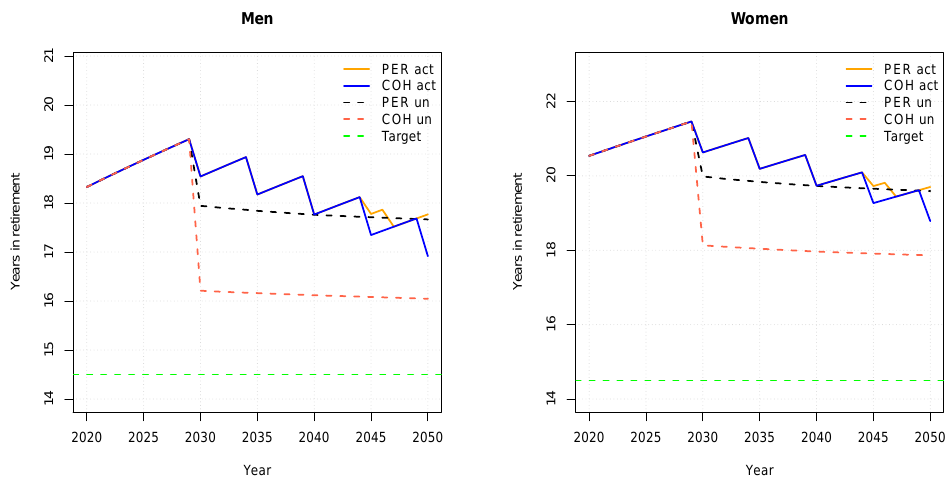
Figure 6. DNK: Expected years in retirement for each sex based on period and cohort projections.